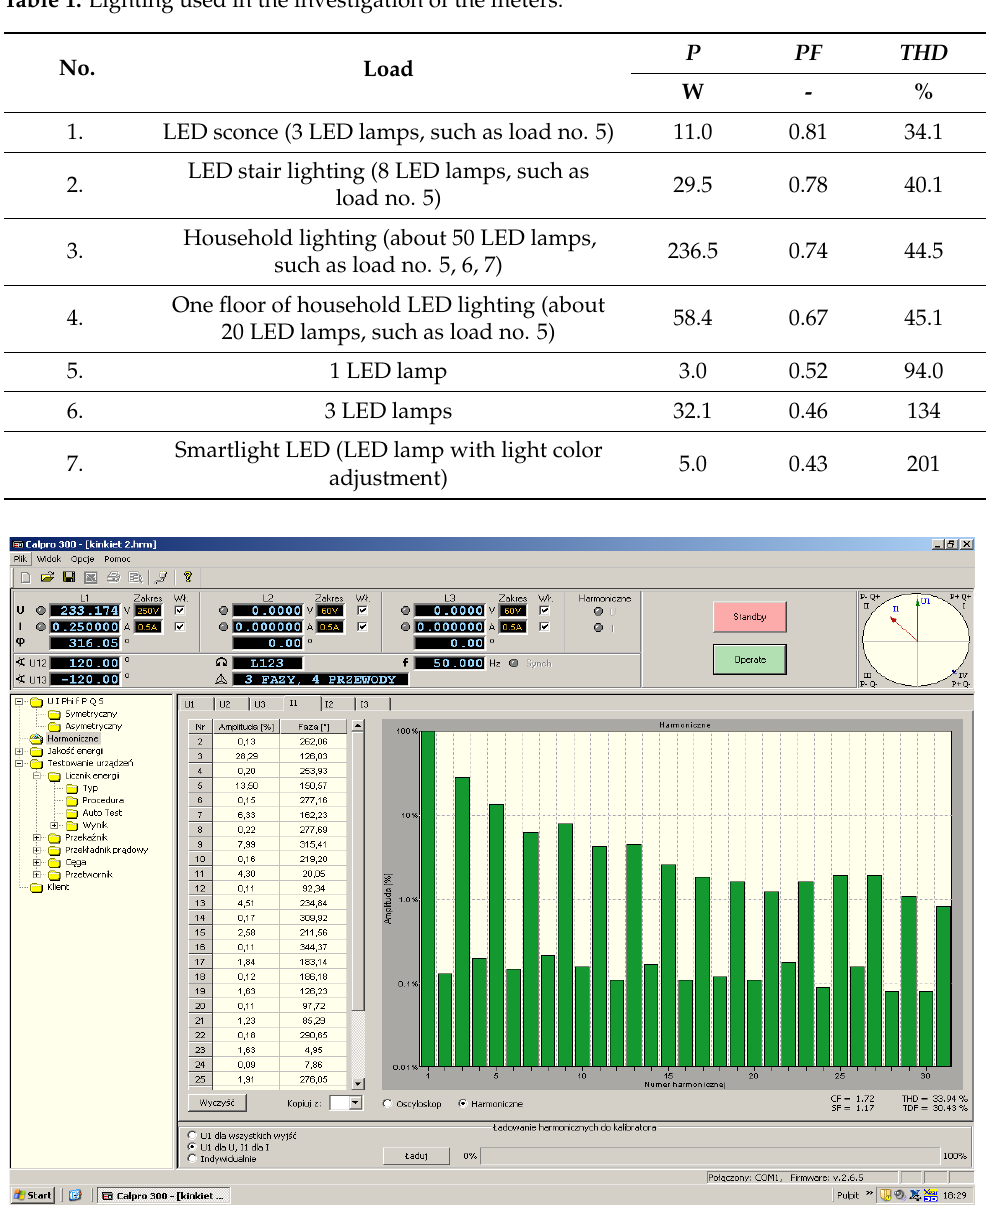
Figure 5. Sample characteristics of the distorted current that was generated by the power calibrator. Amplitudes and phases of 25 harmonics are presented in the table (left of the graph), which provided the magnitudes of the first 31 harmonics.